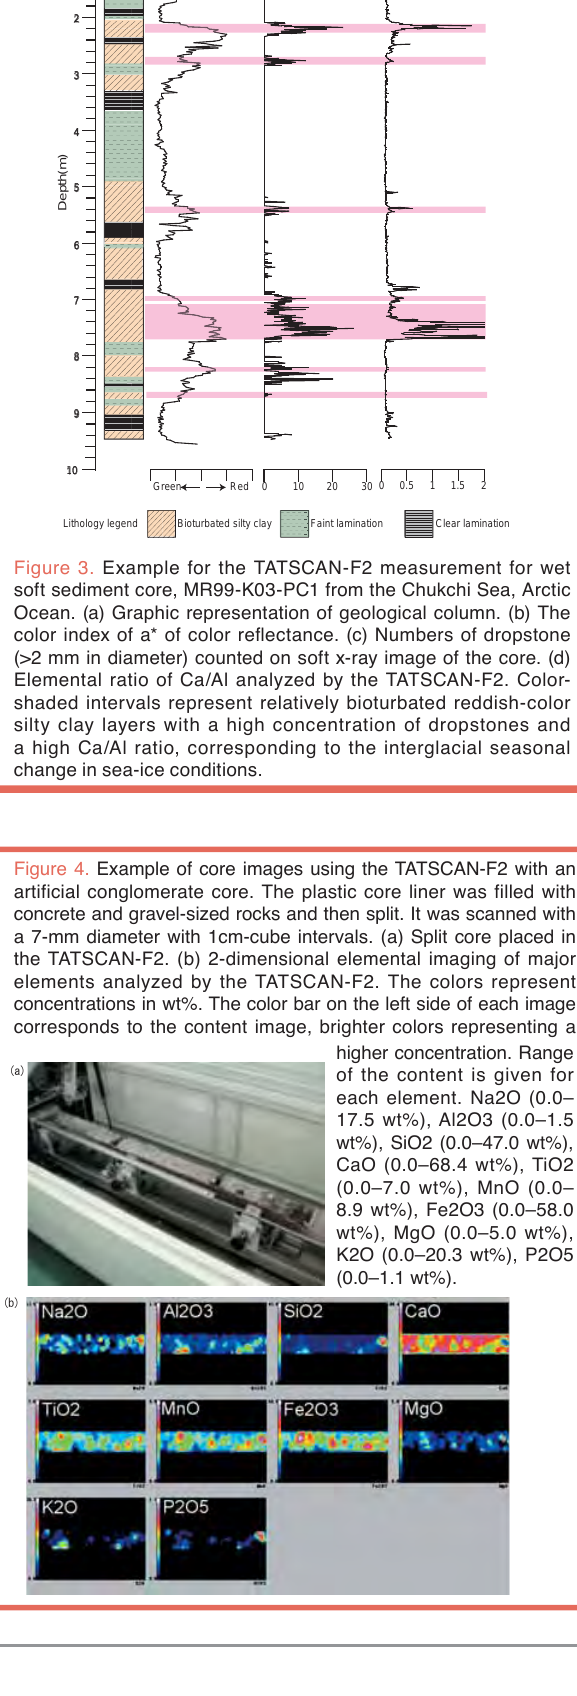
Figure Credits Fig 1: Photo provided by Tatsuhiko Sakamoto. Figs 2 and 4: Data produced by Koichi Iijima and Tatsuhiko Sakamoto. Fig 3: Data produced by Saiko Sugisaki and Tatsuhiko Sakamoto.